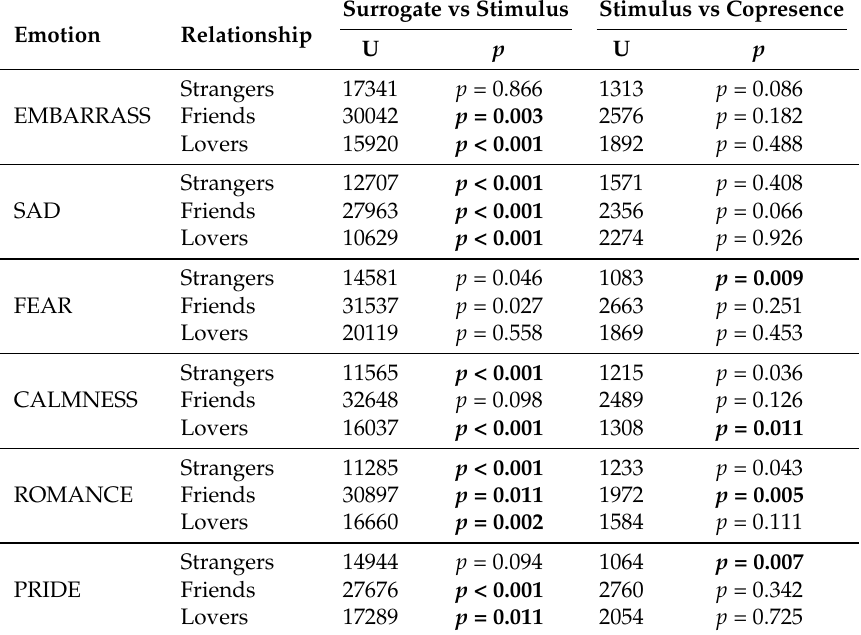
Table 1. Results of the Mann–Whitney tests to compare between surrogate, stimulus, and copresence synchrony for each type of stimulus and type of relationship: Original p -values are reported. The results that remain significant after the correction for multiple hypotheses are in